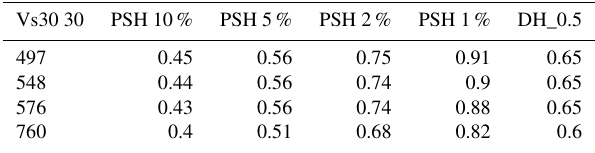
Table 3. Calculated values of